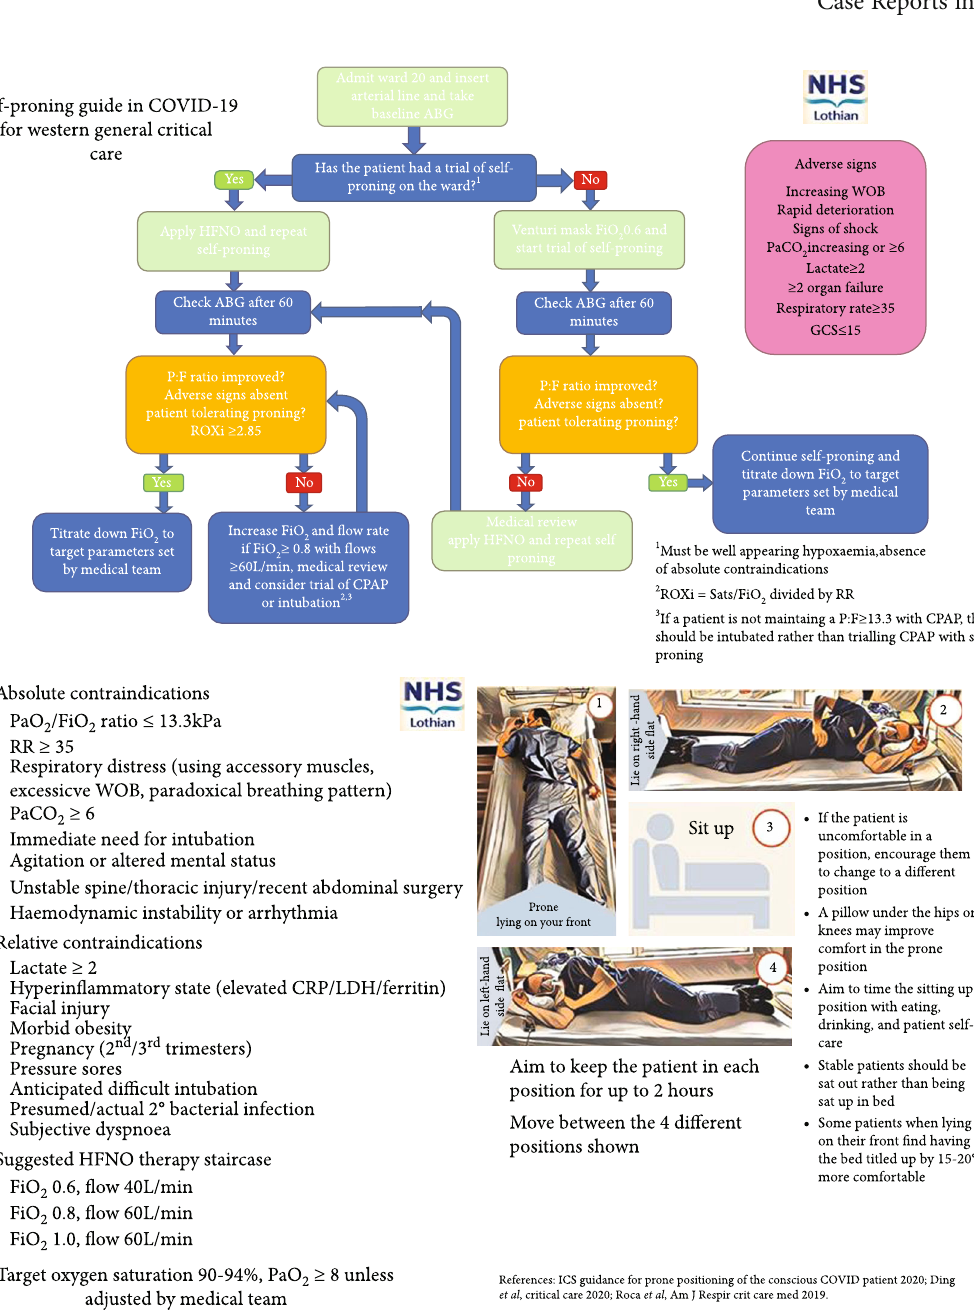
Figure 4: Western General Hospital, Edinburgh, NHS Lothian, NHS Scotland. Awake self-prone